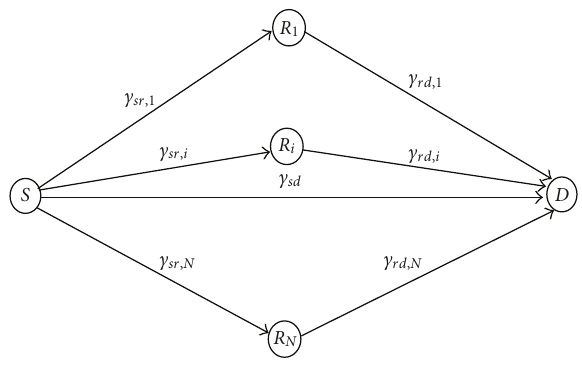
Figure 1: The network